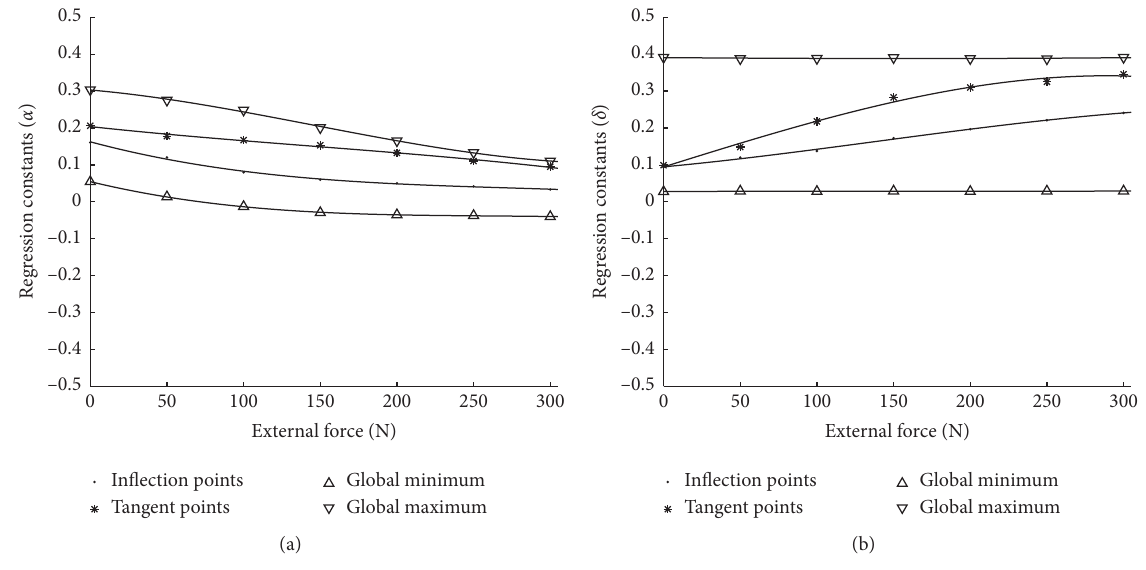
Figure 7: Regression constants of the static pressure model: (a) contraction and (b) pressure.